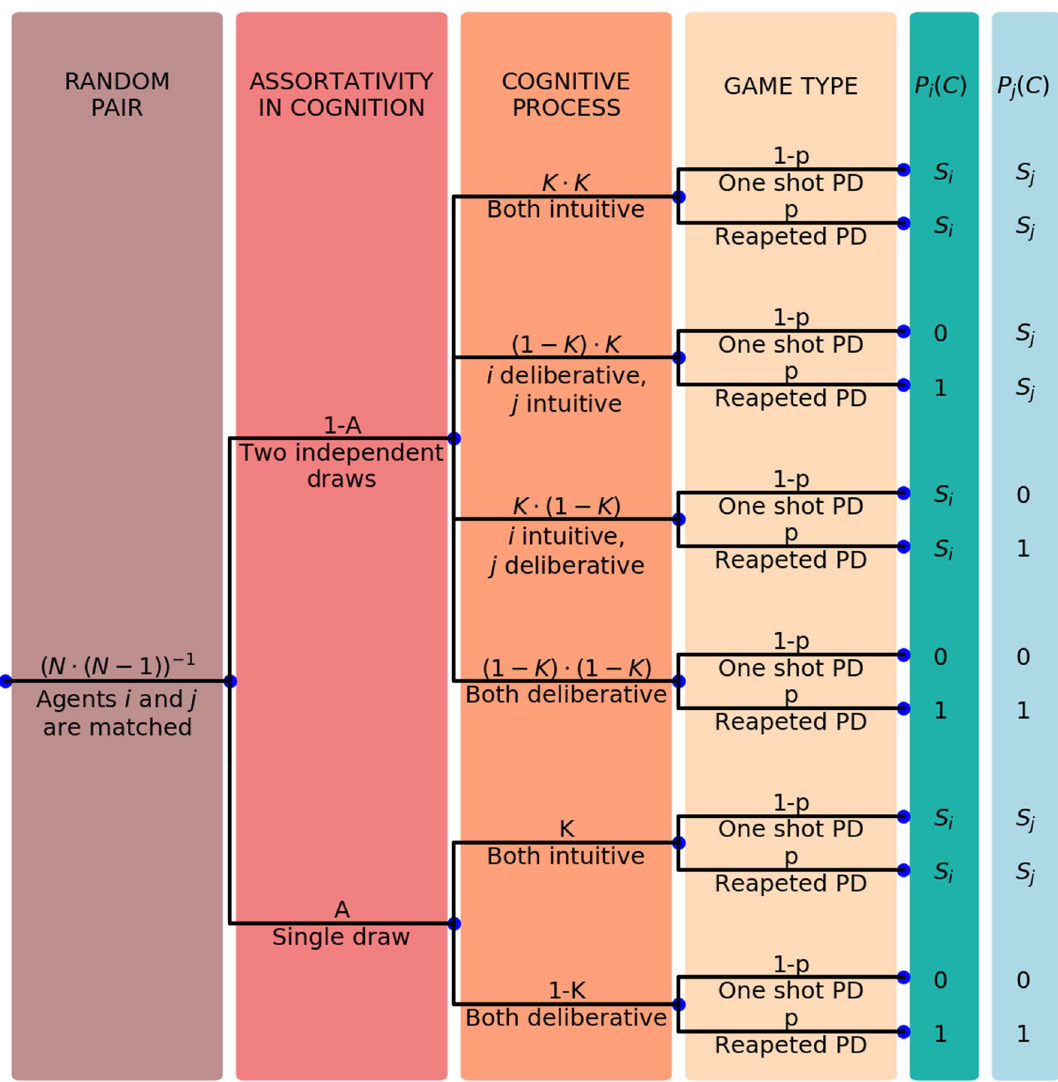
Figure 6. Probabilities are written above branches. For h ∈ { i , j } , P h ( C ) is the probability of cooperation for agents h and S h is the probability that R